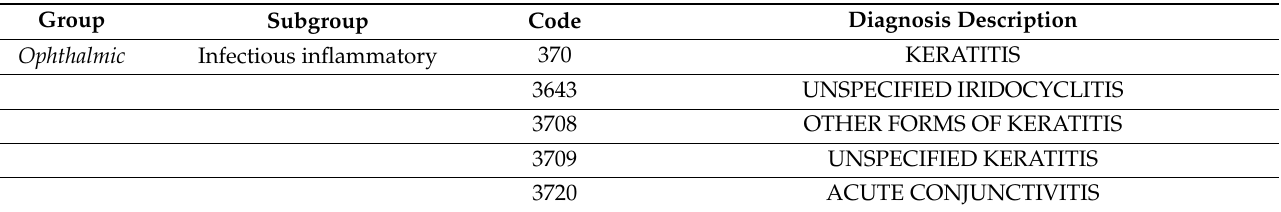
Table A1. Supplement Data—Ophthalmic Diagnoses. Group